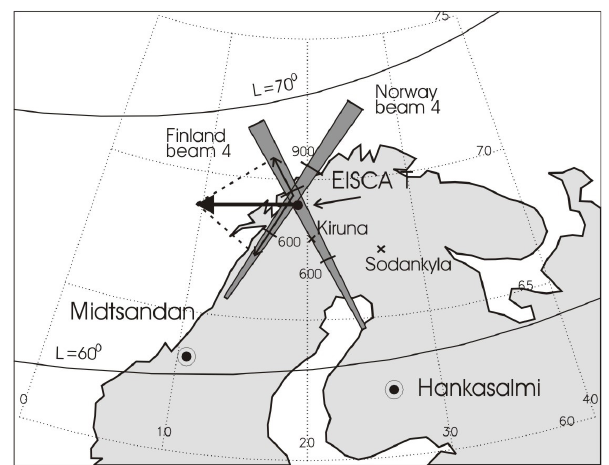
Fig. 1. Field of view of the Hankasalmi Finland STARE radar beam 4, and the Midtsandan Norway STARE radar beam 4 assuming 110km height of scatter. Lines across the beams are slant range marks of 600 and 900km. The STARE irregularity drift velocity vector is the cosine-merged product of the two measured velocities. The solid dot denotes the area where ionospheric parameters were measured by the EISCAT incoherent scatter facility, which includes a UHF transmitter/receiver in Tromsø and receivers in Kiruna and Sodankyl¨a (crosses). The solid thick lines represent the PACE mag- netic